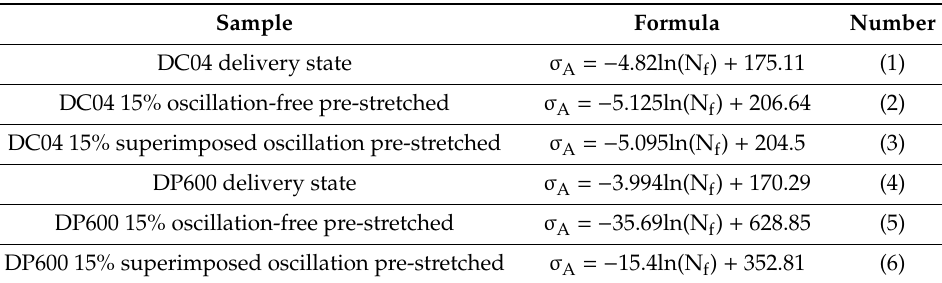
Figure 3. Stress-life curves for flat-tensile test specimens made out of DP600. The fatigue strength curves are determined by trend lines from the diagrams. The trend lines are shown in Figures 2 and 3. The lines are described mathematically by the following formulae in Table 3. The formulas were obtained by drawing the compensation lines between the experimental determined points: Table 3. Mathematical course of the trend